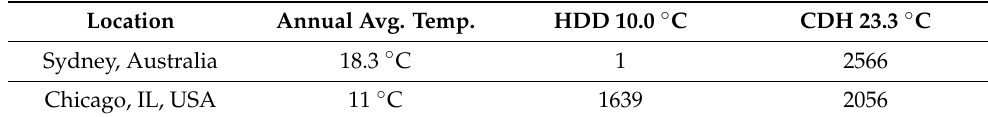
Table 9. Monthly climatic design conditions of Sydney and Chicago